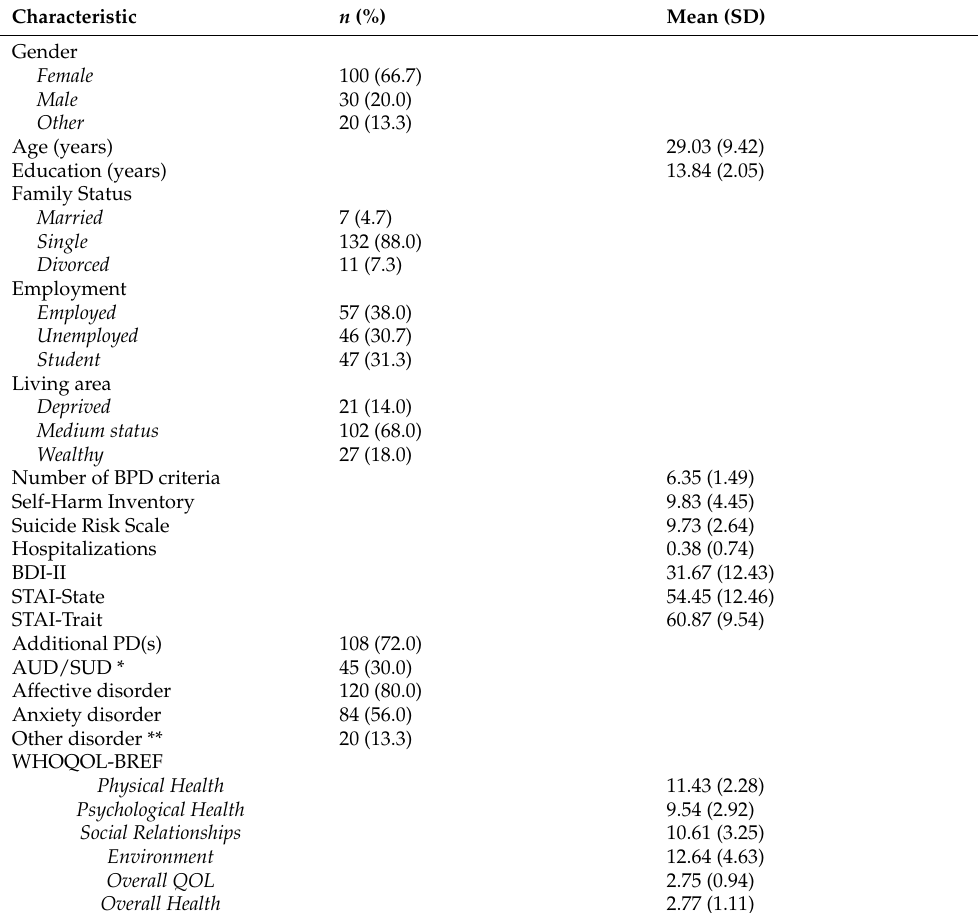
Table 1. Demographic, and clinical characteristics of the